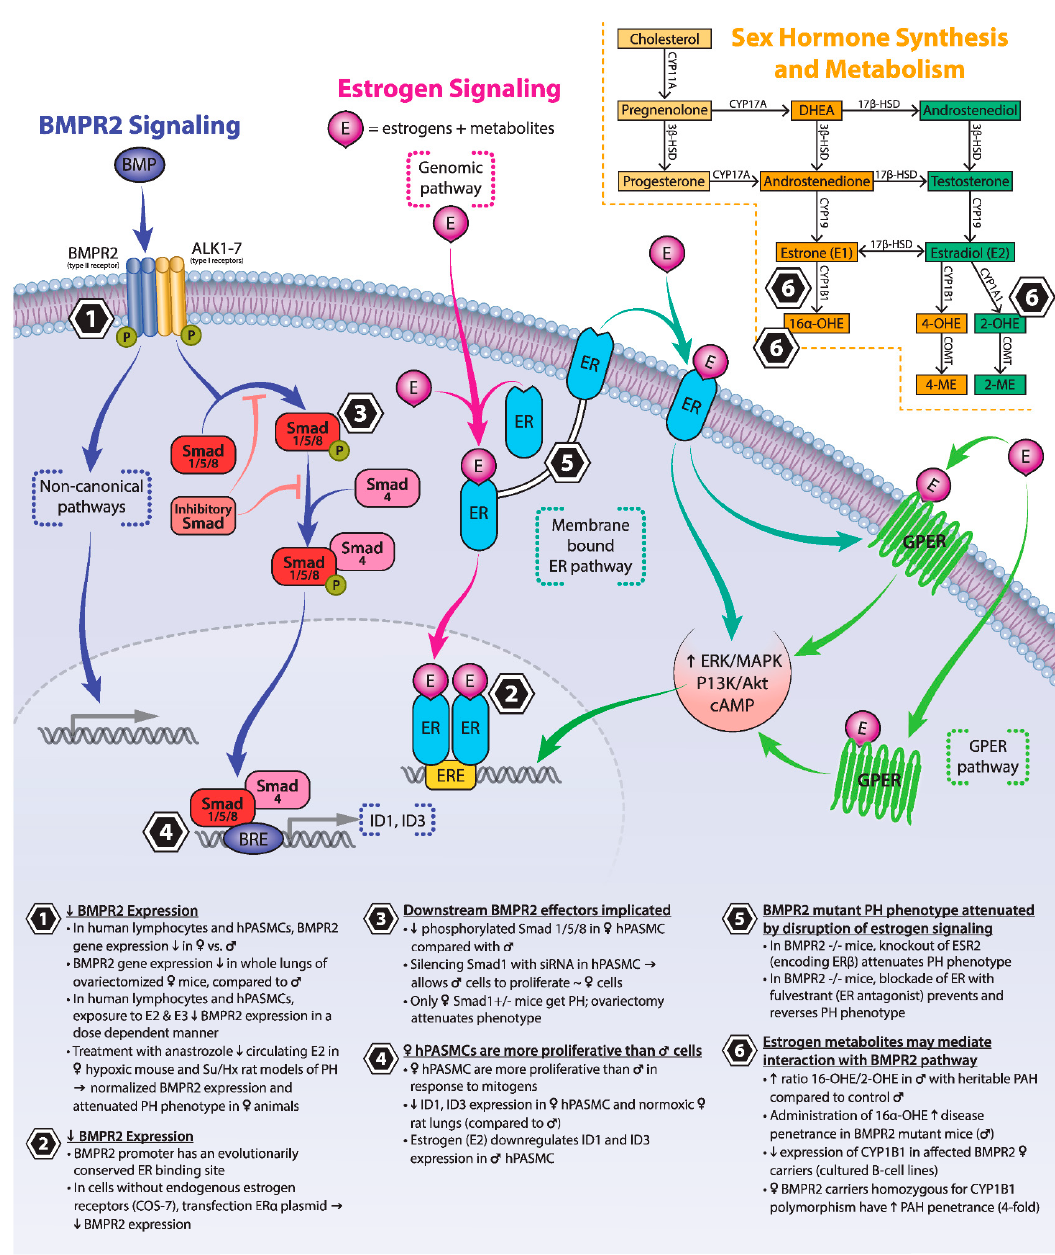
Figure 1. Overview of sex hormone synthesis and metabolism and the interaction between estrogen and BMPR2 signaling pathways. BMP = bone morphogenetic protein; BMPR2 = bone morphogenetic protein receptor 2; BRE = BMP response element; DHEA = dehydroepiandrosterone; E3 = estriol; ER = estrogen receptor; ERE = estrogen response element; GPER = G-protein-coupled estrogen receptor; hPASMC = human pulmonary artery smooth muscle cell; PH = pulmonary hypertension.